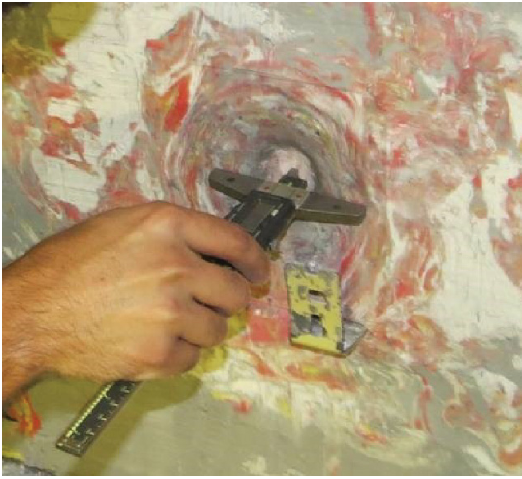
Figure 3. Measurement of the depth in the clay witness caused by the projectile impact. Source: authors.